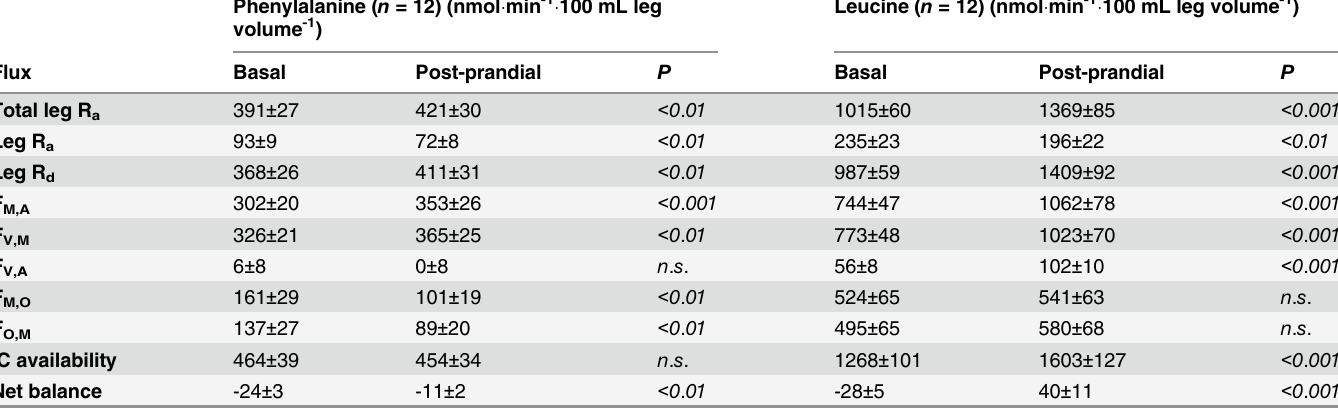
Table 2. Leg phenylalanine and leucine kinetics.